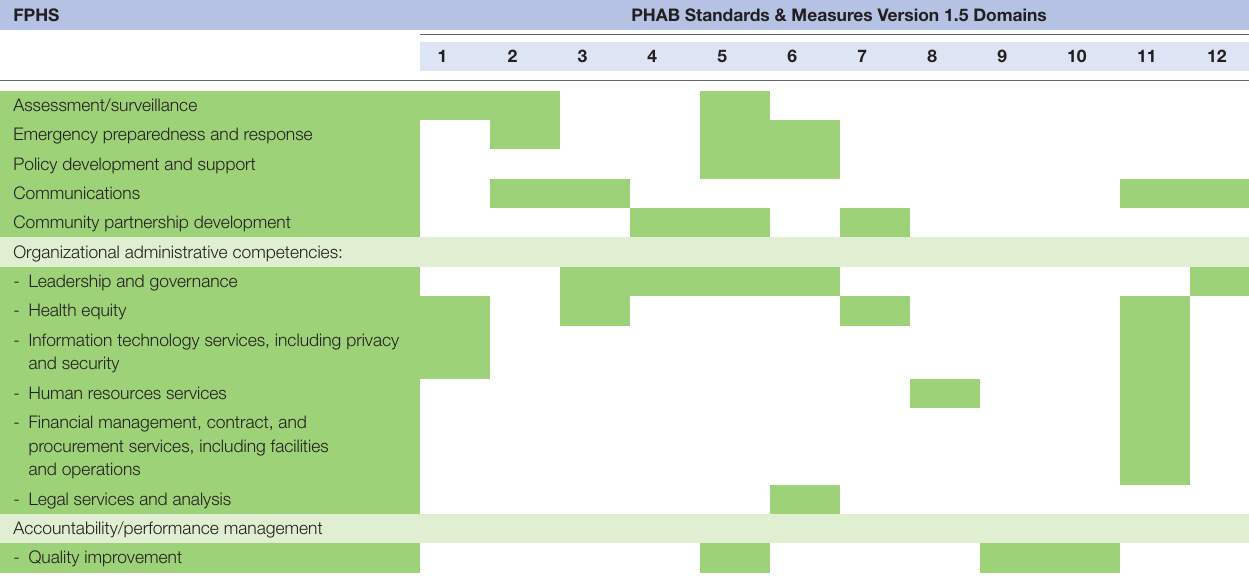
TABLE 1 | Overview of FPHS and PHAB Domain alignment.